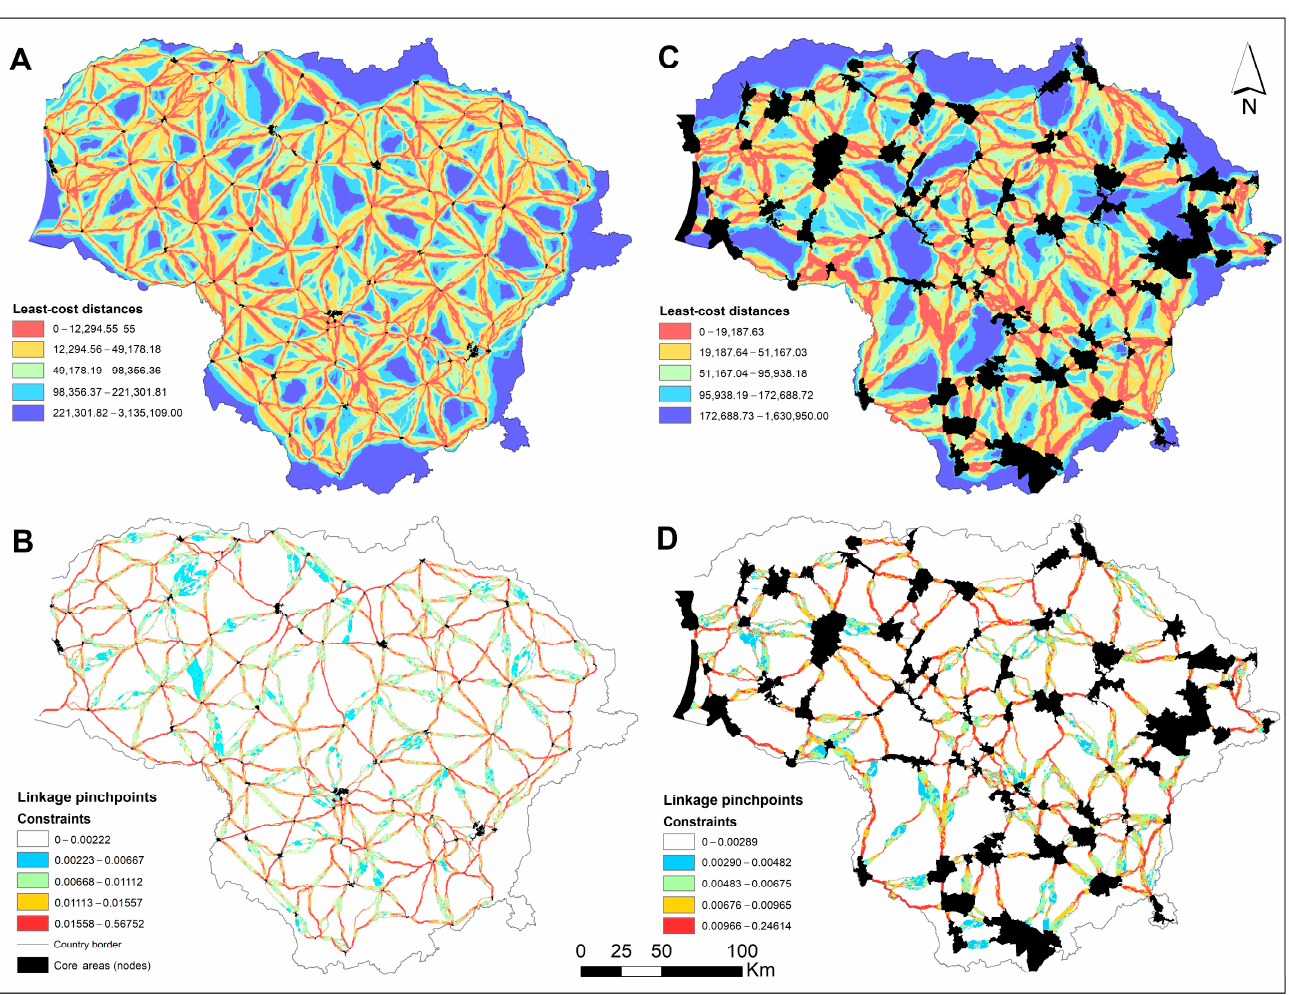
Figure 4. Urban corridor least-cost distance ( A ), urban pinch point ( B ), and wildlife corridor least-cost distances ( C ) and wildlife pinch-point ( D ) quantile maps. Urban ( A , B ) and wildlife ( C , D ) core areas are coloured in black.